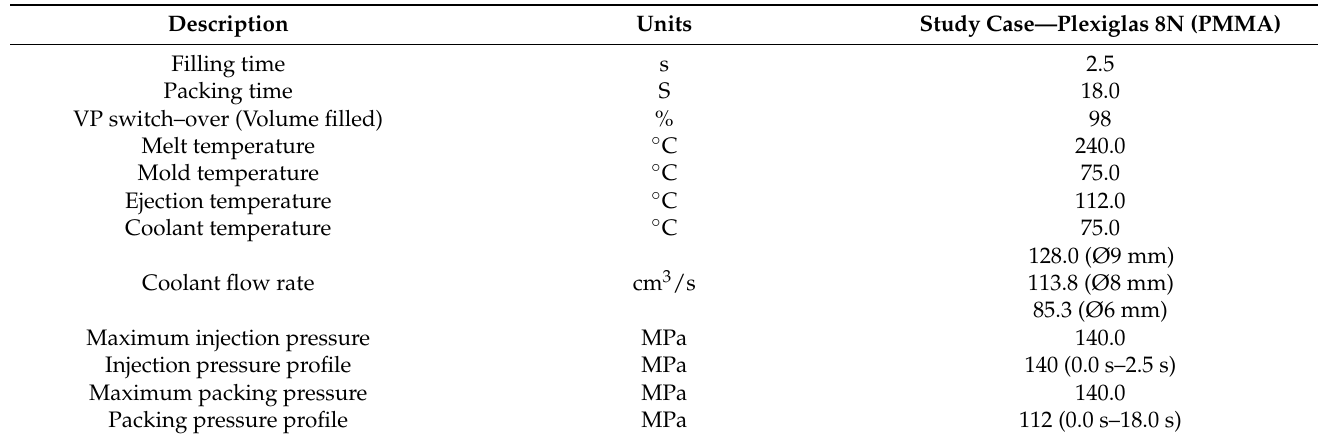
Table 9. Magnitude of the technological parameters defined for the numerical